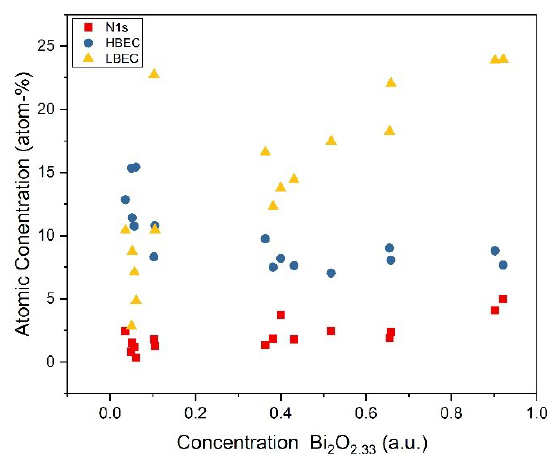
Figure 6. Phase fraction of non-stoichiometric bismuth oxide vs. atomic concentration of nitrogen, LBEC, and HBEC.